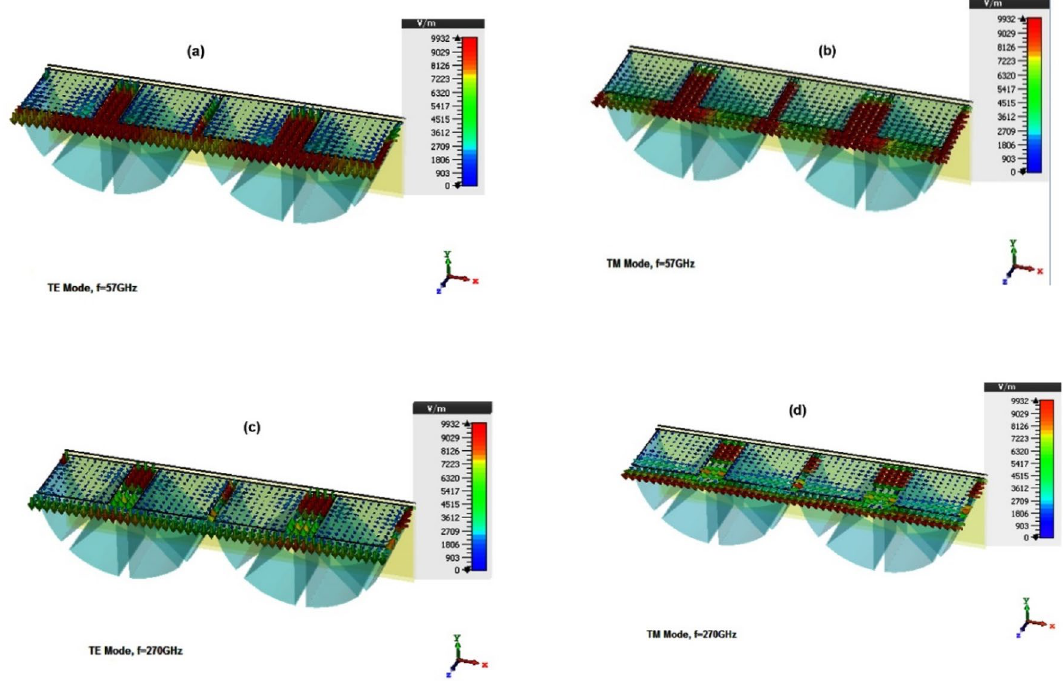
Figure 5. The E-field distributions at ( a ) f = 57 GHz, TE mode ( b ) f = 57 GHz, TM mode ( c ) f = 270 GHz, TE mode and ( d ) f = 270 GHz,